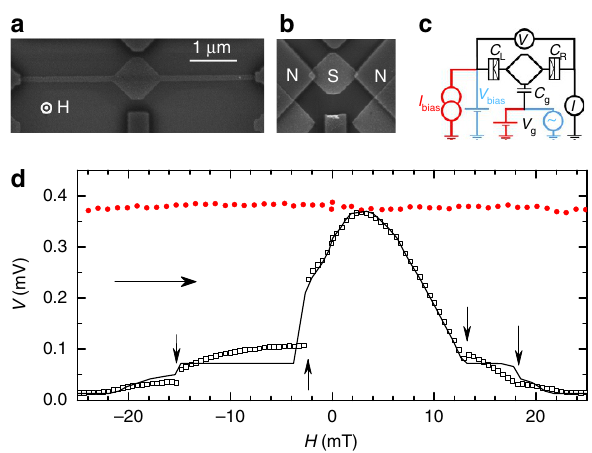
Figure 2 | Layouts of the samples and results of d.c. measurements. Electron micrographs of ( a ) Sample A and ( b ) Sample B. ( c ) Schematic picture of the device with its electrical connections where the red and black lines correspond to the d.c. measurements, while blue and black ones to the pump measurements. ( d ) Evolution of the voltage at a fixed bias current I bias ¼ 10pA at the gate voltage C g V g / e ¼ n g ¼ 0.5 suppressing the Coulomb energy with the magnetic field for Sample A (red filled circles) and Sample B (black open squares). The vertical arrows correspond to the applied field values at which the vorticity m increases step by step by one from (cid:3) 2 to 2 as the field is swept from (cid:3) 25 to 25mT. The horizontal arrow shows the direction of the field sweep. The solid black line is the theoretical result for this measurement. The experimental uncertainty has been estimated as B 3 m V from the noise of the